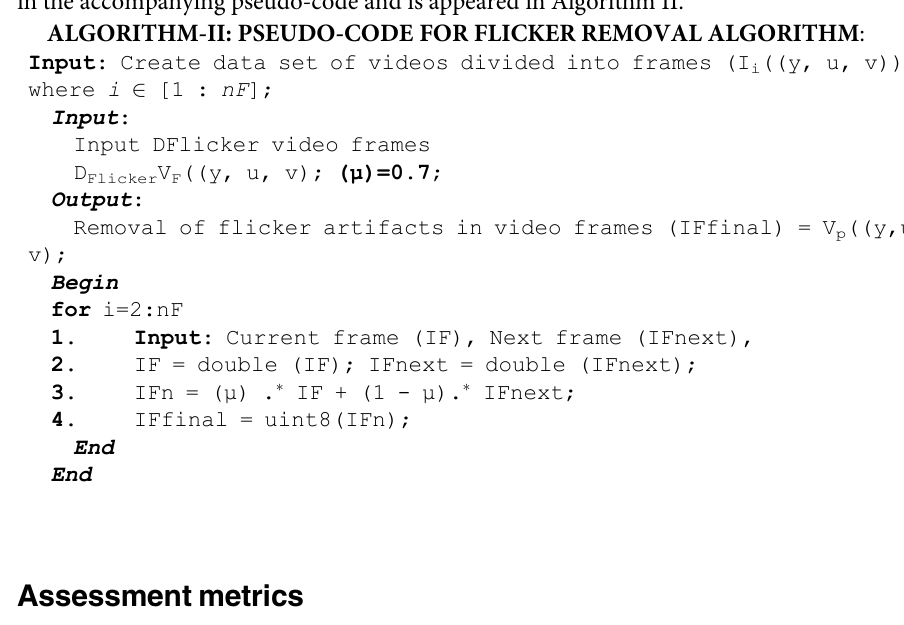
ALGORITHM-II: PSEUDO-CODE FOR FLICKER REMOVAL ALGORITHM